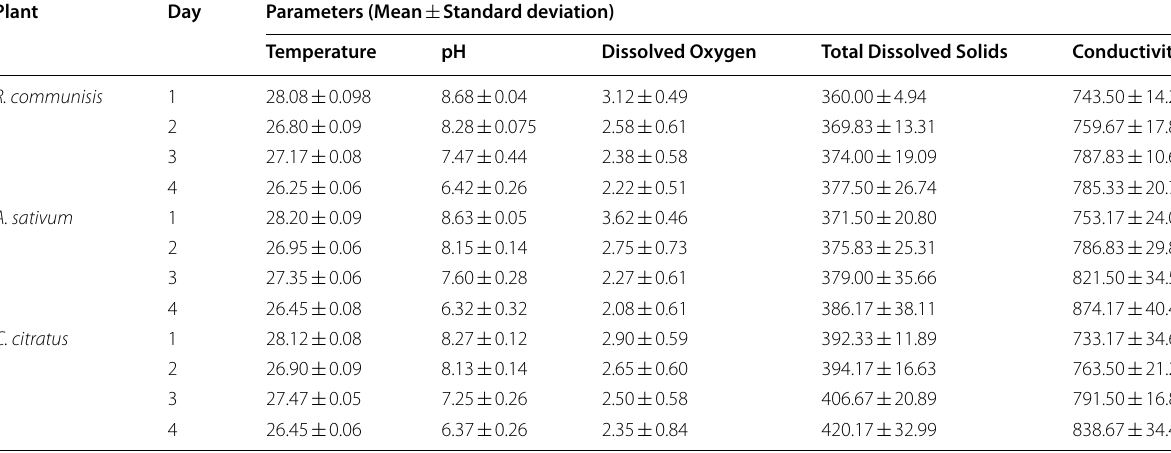
Table 2 Comparison of physicochemical parameters of ethanolic leaf extracts of r. communis, a. sativum and c. citratus